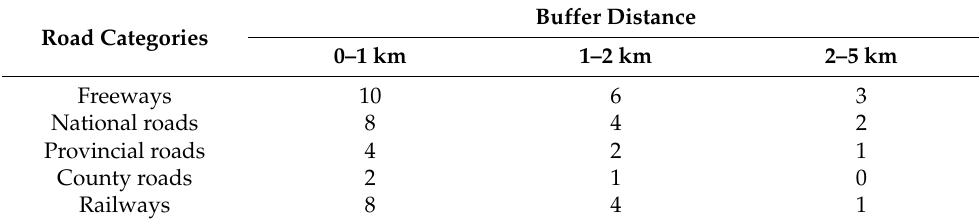
Table 2. Human influence scores of different road levels on the